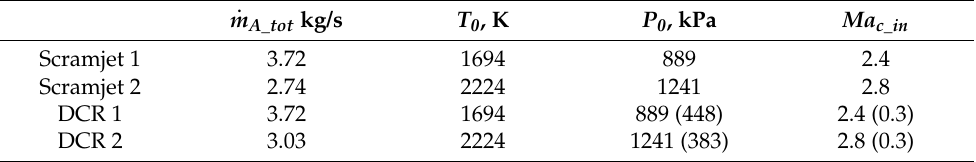
Table 2. Boundary conditions of DCRs and scramjets.